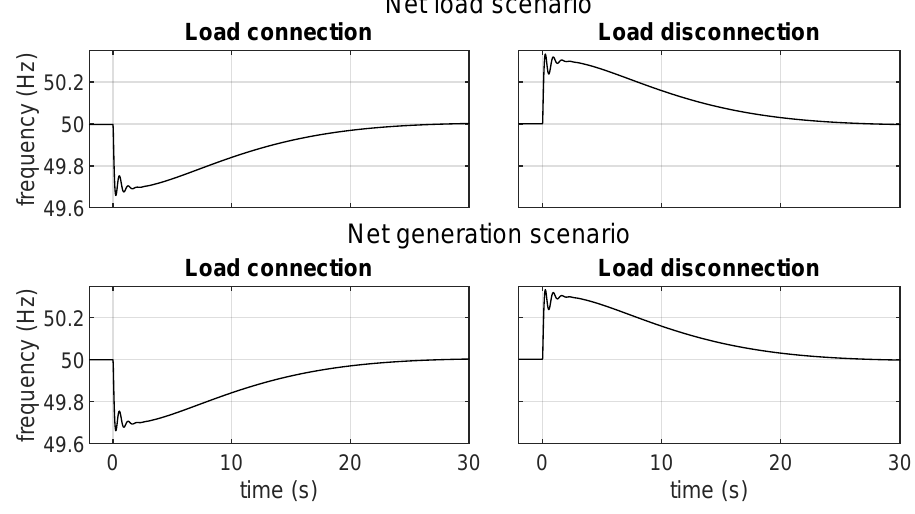
Figure 18. Frequency variations observed in the MV AC network for the net load ( up ) and net generation scenarios ( down ): under-frequency due to load connection ( left ) and over-frequency due to load disconnection ( right